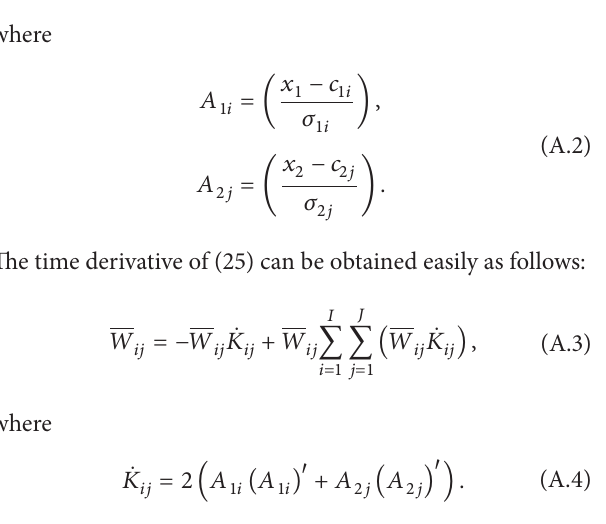
Figure5:Timeresponsesoftheroll( 𝜙 ),pitch( 𝜃 )andyaw( 𝜓 )angles (blue line) compared with their reference (red)